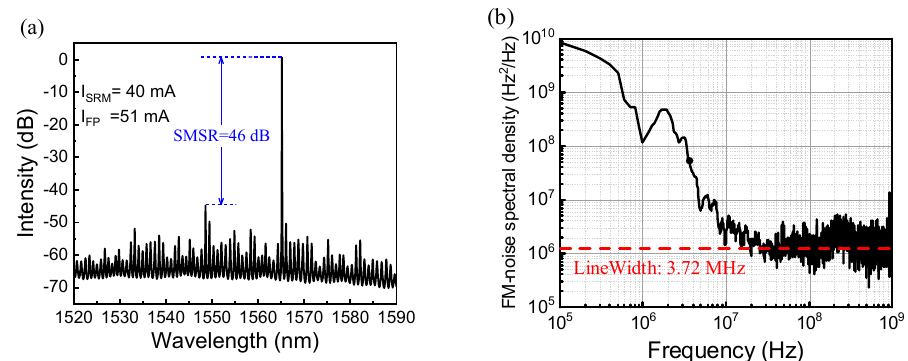
Figure 4. ( a ) The lasing spectrum of HSRRLs at injection currents of I SRM = 51 mA and I FP = 40 mA. ( b ) FM noise spectrum curve of 1565.2 nm wavelength.